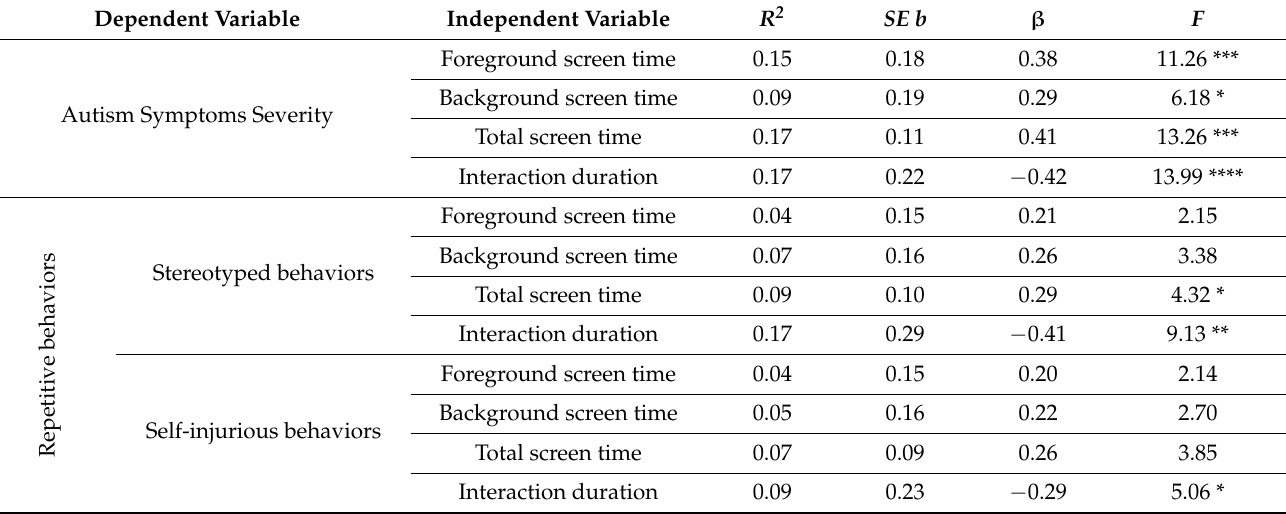
Table 3. Linear regression for variables predicting toddlers’ ASD symptoms